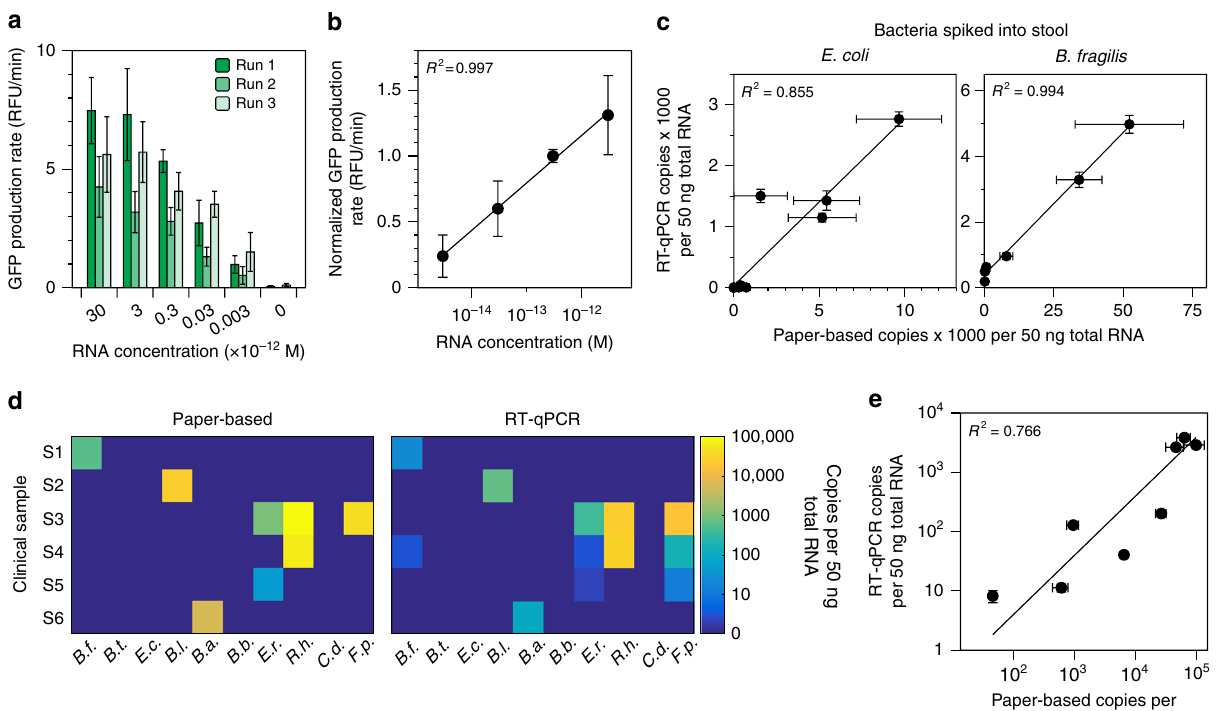
Fig. 4 Quanti fi cation of NASBA-mediated ampli fi cation using toehold switch sensors. a Run-to-run variation in mRNA standards ampli fi ed by NASBA and measured by toehold sensors. mRNA standards for the B. thetaiotaomicron species-speci fi c sensor were run in NASBA reactions for 30 min. Outputs from NASBA reactions were used to activate toehold switch sensors in paper-based reactions. b Calibration curve for the B.t . species-speci fi c mRNA. Values from each standard in the individual runs in a were normalized to the 300 fM standard for that speci fi c run and averaged across runs. c Quantifying species-speci fi c mRNAs in stool. E. coli or B. fragilis cells were spiked into 150 mg of a commercial stool sample and processed for total RNA. Species- speci fi c mRNAs were quanti fi ed using our paper-based platform and RT-qPCR. d Analysis of clinical stool samples. Six clinical stool samples were processed for total RNA and analyzed by our paper-based platform and RT-qPCR. Data and s.d. are shown in Supplementary Figure 11. e Correlation of clinical sample results. Non-zero paper-based concentrations from d were compared to RT-qPCR determined values. Data represent mean values. Paper- based error bars in a , c , and e represent s.d. from nine replicates (three biological replicates (NASBA reactions) × three technical replicates (paper-based reactions)). RT-qPCR error bars in c and e represent s.d. from six replicates (two biological replicates (RT reactions) × three technical replicates